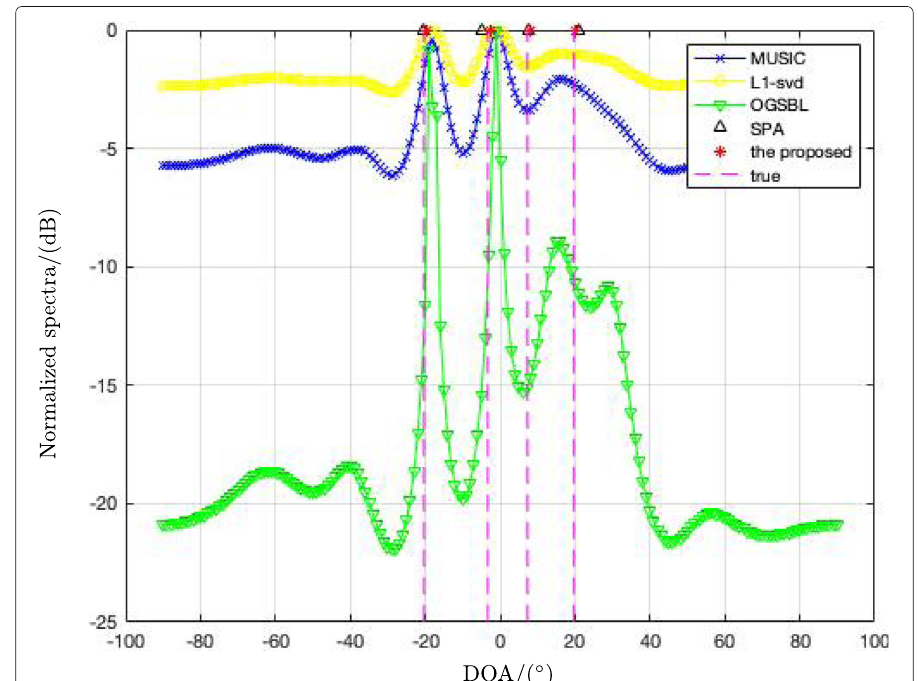
Fig. 1 Spectral of five algorithms in SNR = 0